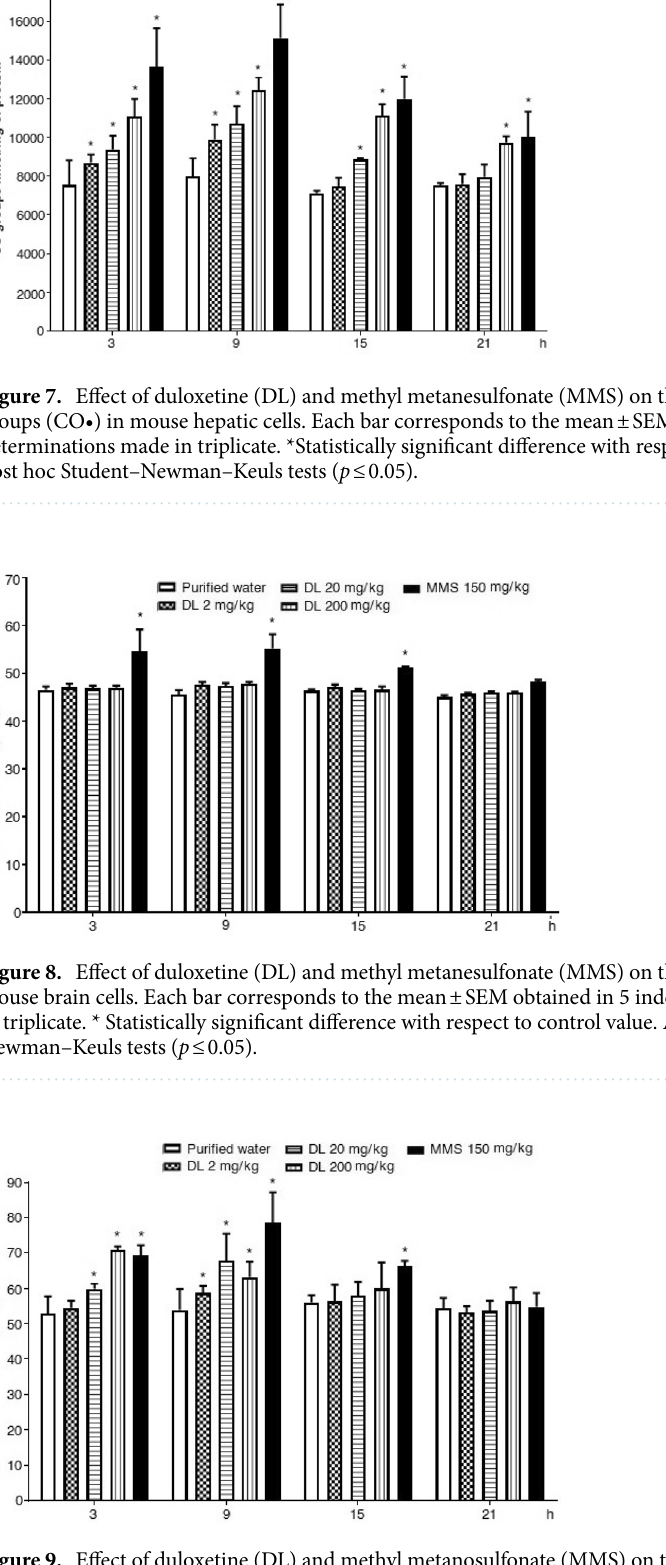
Figure 9. Effect of duloxetine (DL) and methyl metanosulfonate (MMS) on the content of nitrites (NO 2 ) in mouse hepatic cells. Each bar corresponds to the mean ± SEM obtained in 5 independent determinations made in triplicate. *Statistically significant difference with respect to control value. ANOVA and post hoc Student– Newman–Keuls test ( p ≤